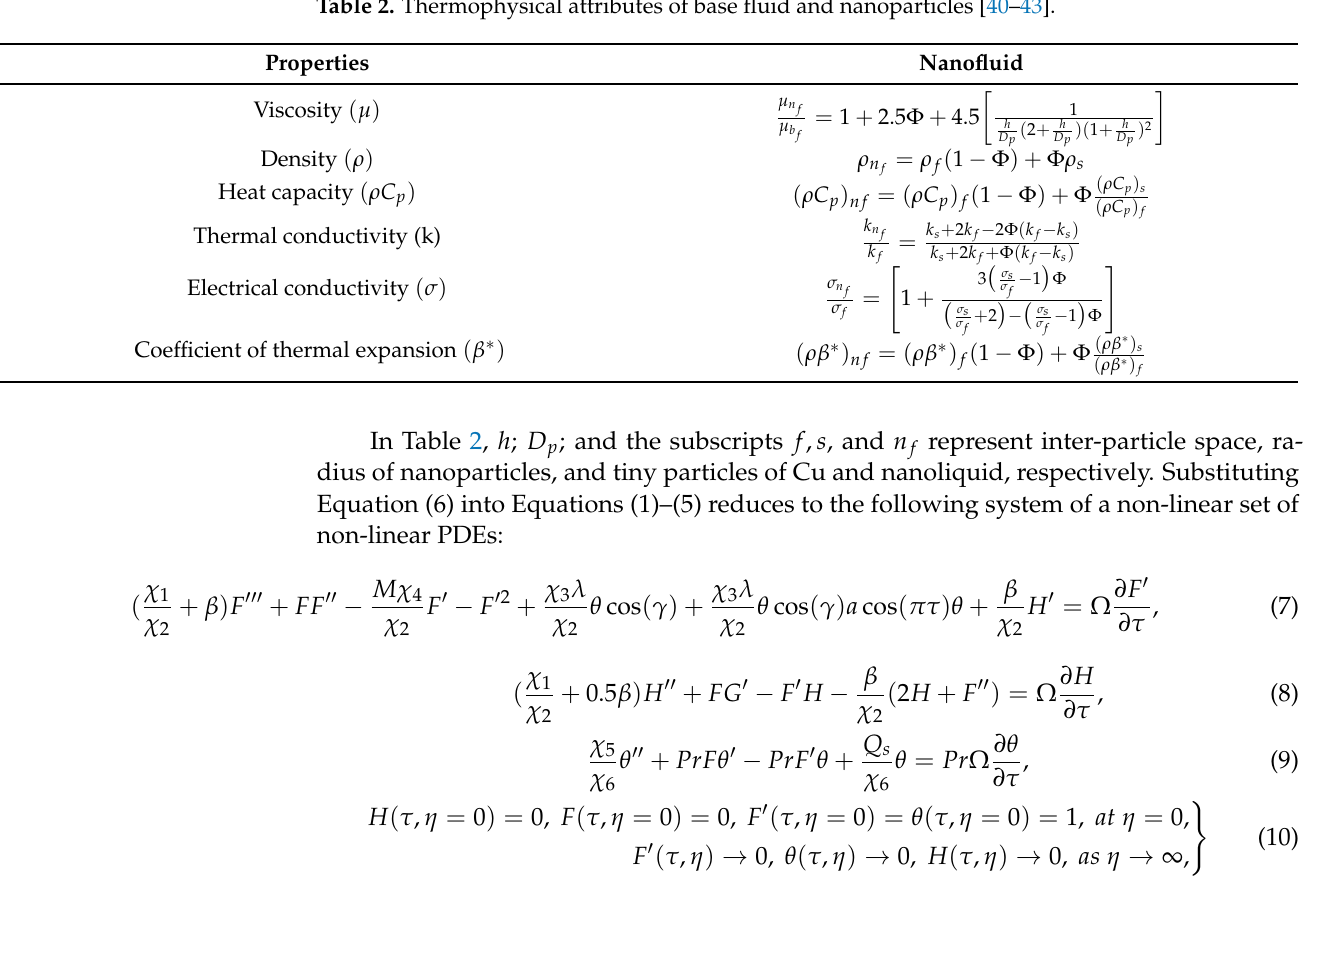
Table 2. Thermophysical attributes of base fluid and nanoparticles